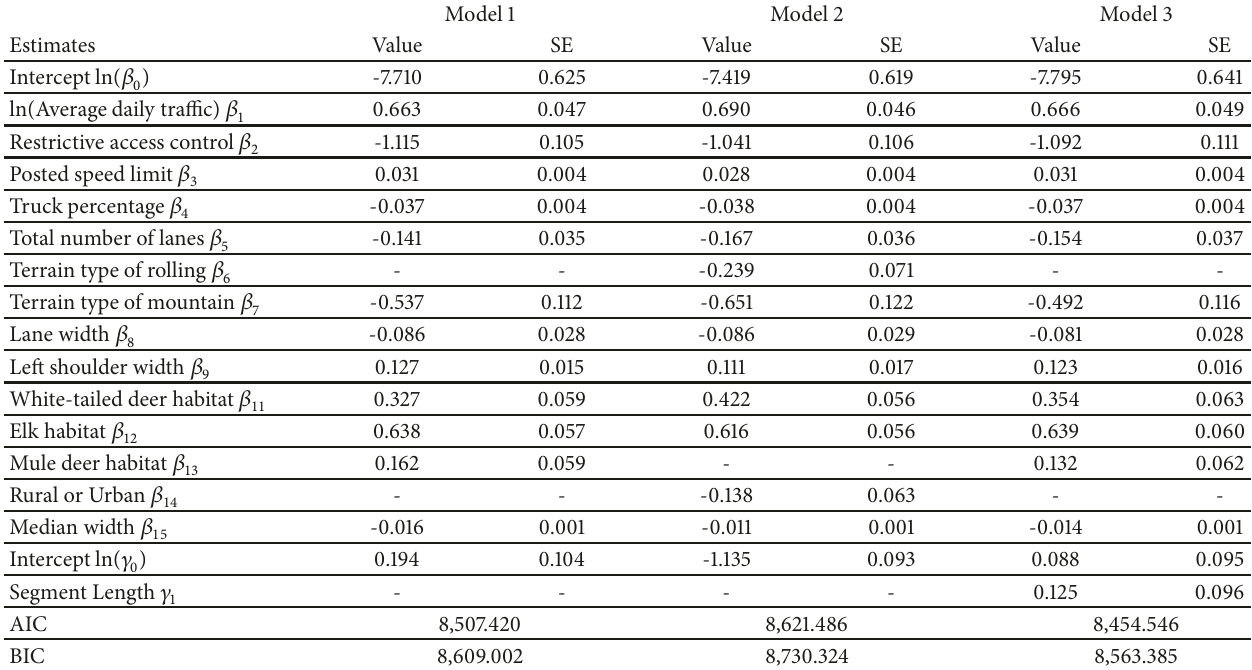
Table 11: Modelling results for the GNB model using the reported AVCs